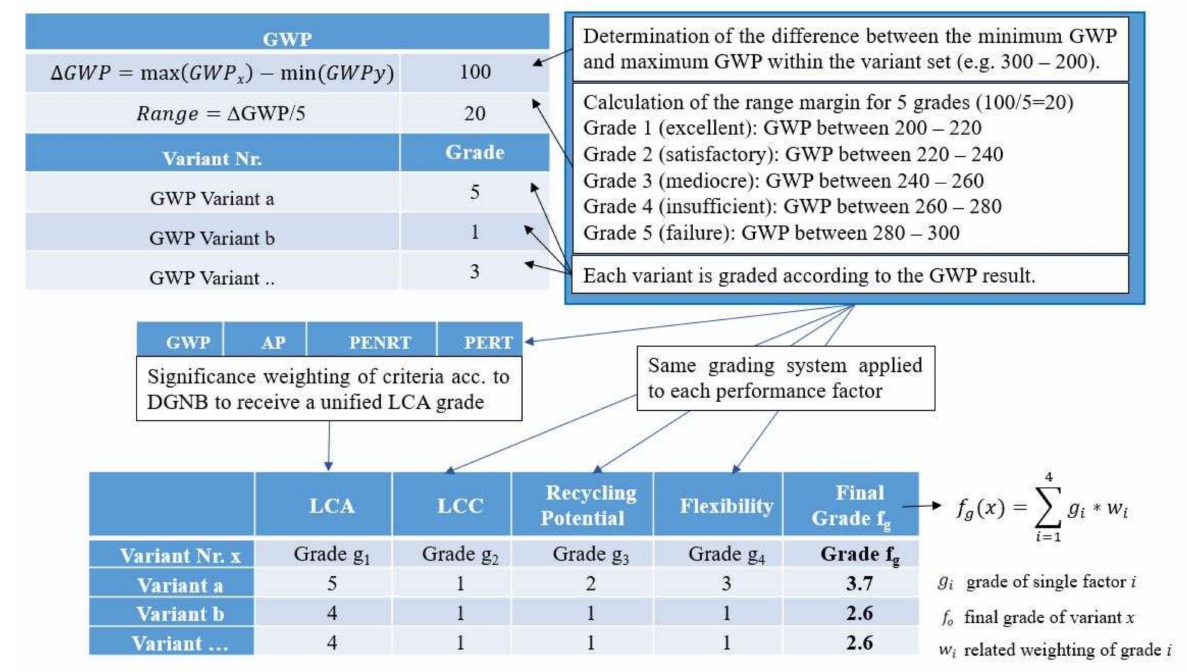
Figure 5. Grading methodology to make the performance of building variants rapidly